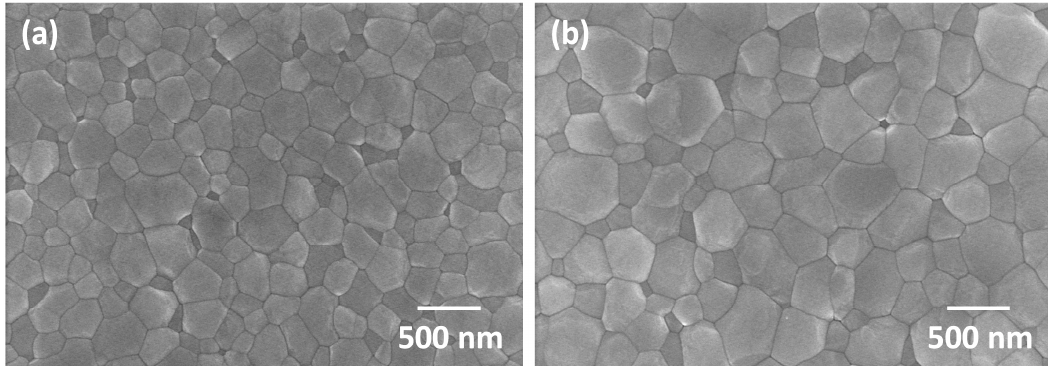
Figure 8. SEM micrographs of two-step sintered samples prepared from as-received powder. The temperatures in each label are T1 and T2 respectively. Figure 9. SEM micrographs of ( a ) a two-step sintered sample (T1 = 1400 °C, T2 = 1350 °C, t2 = 5 h) and ( b ) a conventionally sintered sample, both prepared using ball milled powder.